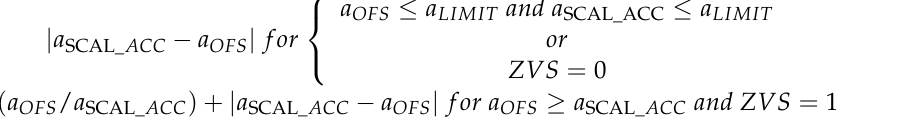
error is evident. Meanwhile, the displacement estimated from the complementary filter (green) is kept close to the encoder values even when OFS provides data with an error. In addition, the complementary filter allows earlier detection of velocity change, realized by the accelerometer, than just by using OFS. This, as a result, reduces the error in the initial part of the acceleration phase and in the final part of the deceleration phase, when the actual velocity is too low for the OFS sensor to detect it. Figure 19. Magnified view of part of Figure 18, presenting a close comparison of displacements.